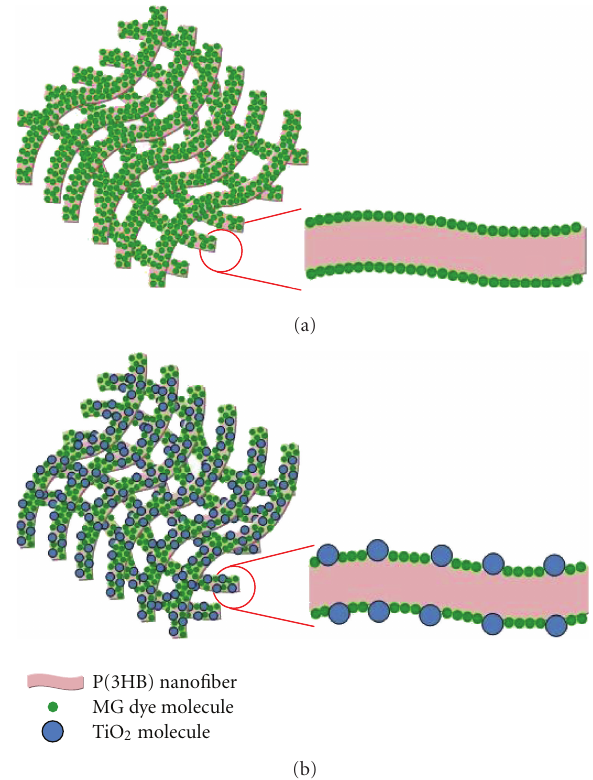
Figure 3: Schematics showing the proposed mechanism involved in the MG dye molecules adsorption onto electrospun (a) P(3HB) and (b) P(3HB)-50wt% TiO 2